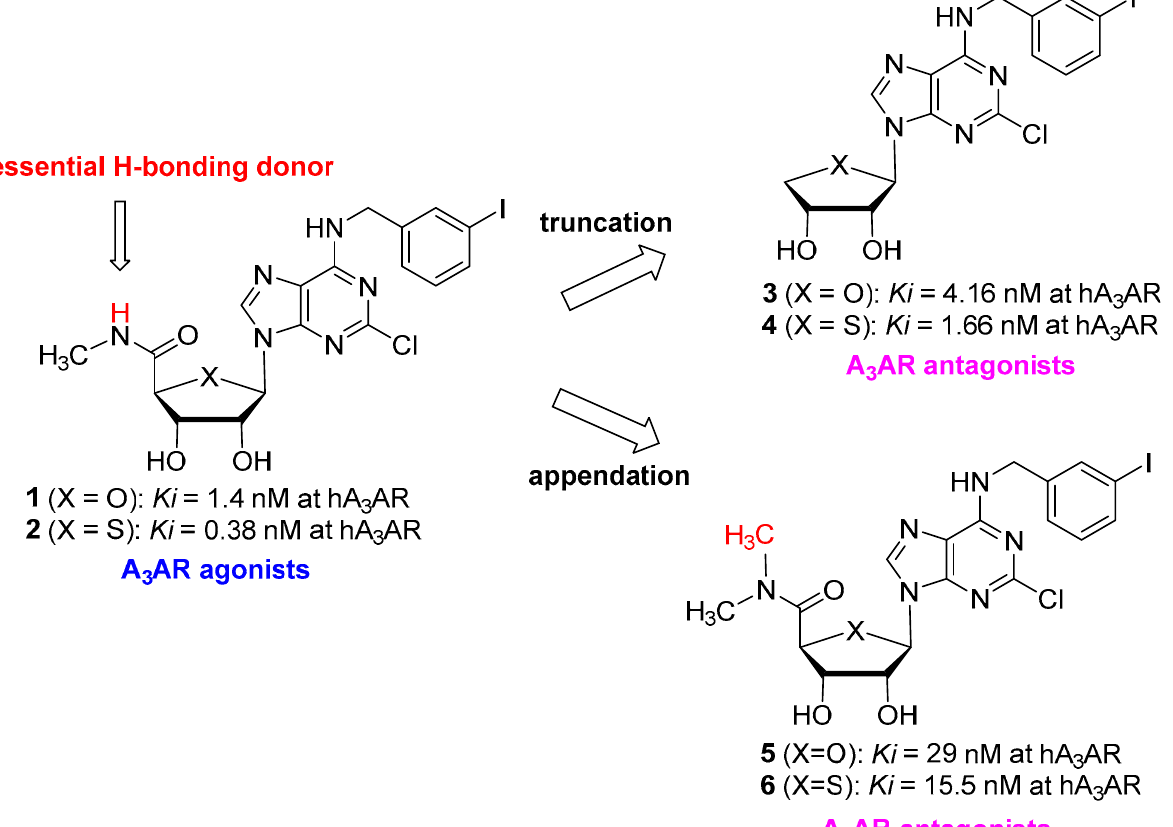
Figure 1. Conversion of A 3 AR agonists to A 3 AR antagonists.